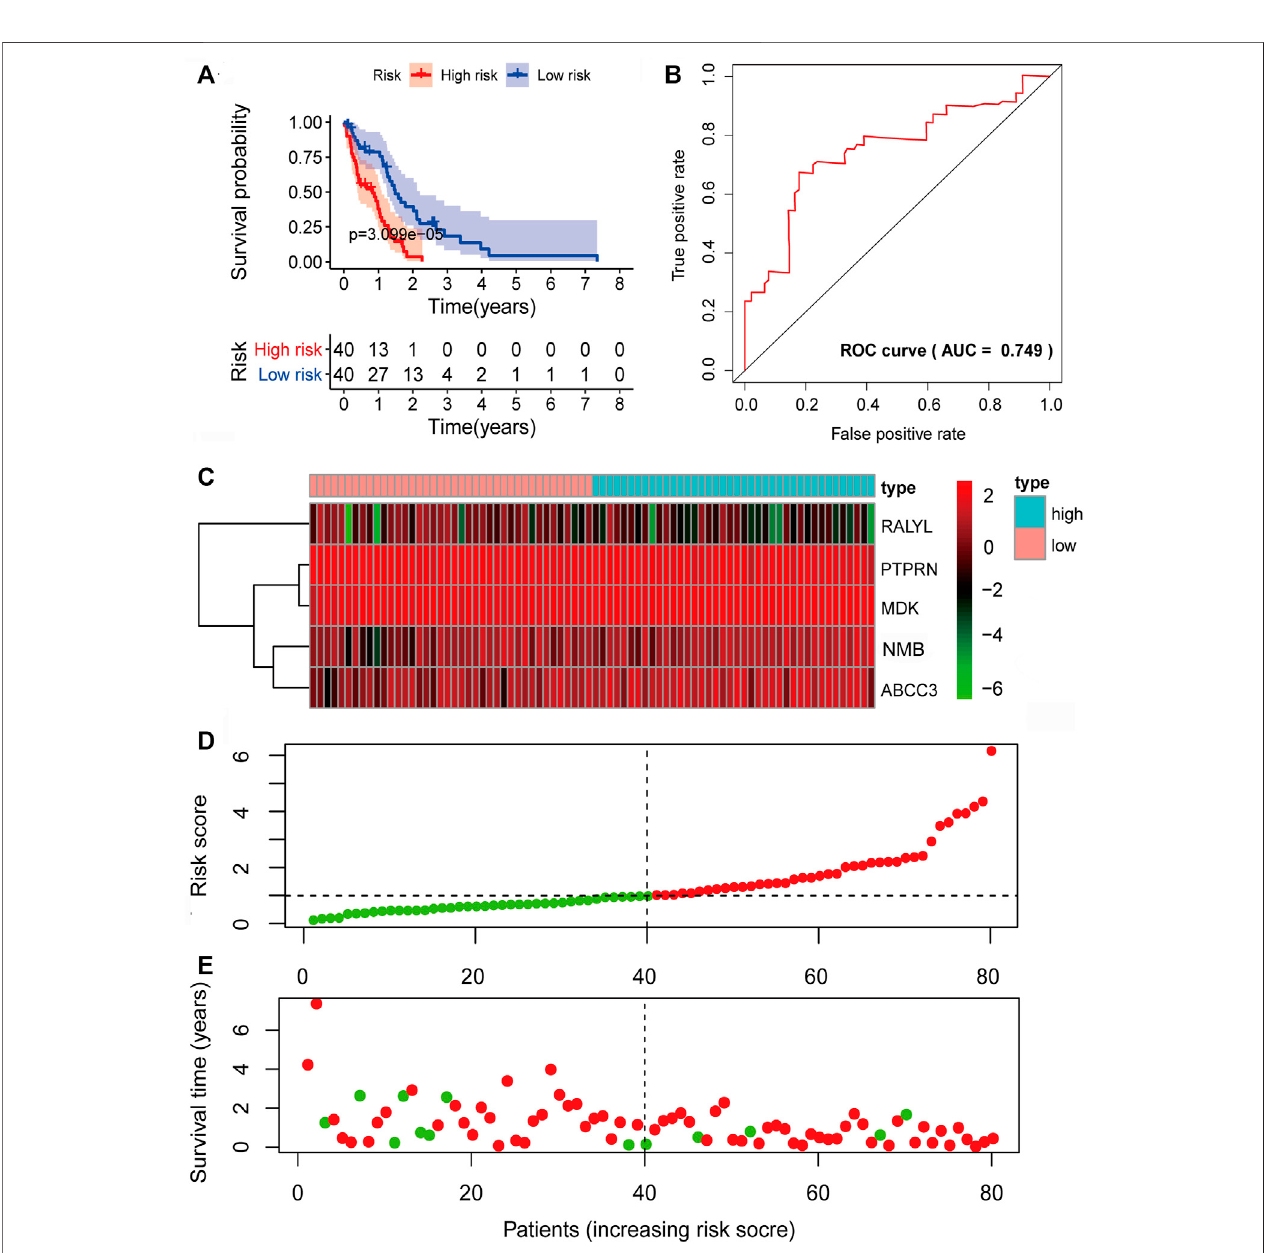
FIGURE 4 | Prognostic evaluation of the fi ve-mRNA signature in the training set. (A) Kaplan – Meier survival curve for patient overall survival (OS) in the training set. (B) Receiver operating characteristic (ROC) curve analysis to compare the sensitivity and speci fi city of the prognosis prediction model. The mRNA expression patterns (C) , risk score distribution (D), and survival status of patients (E) in the high- and low-risk groups by the fi ve-mRNA signature. Green dot, alive; red dot, dead.